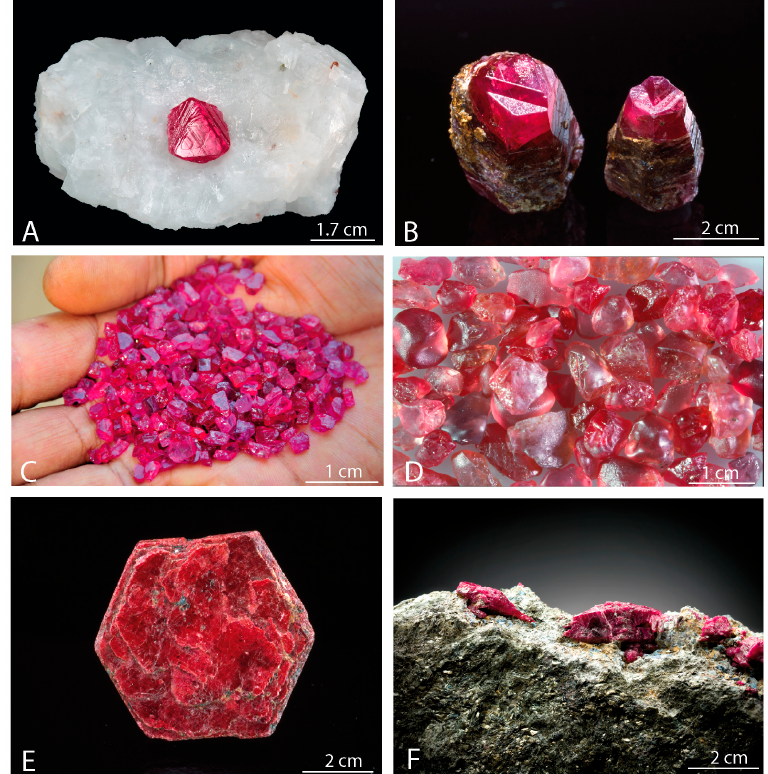
Figure 1. Rubies worldwide. ( A ) Ruby crystal (1.7 cm × 1.7 cm × 0.5 cm) in marble from Bawpadan, Figure 1. Rubiesworldwide. ( A )Rubycrystal(1.7cm × 1.7cm × 0.5cm)inmarblefromBawpadan, Mogok, Mogok, Myanmar. Photo: Louis-Dominique Bayle © le Règne Minéral; ( B ) rubies (from left to right: Myanmar. Photo: Louis-Dominique Bayle © le R è gne Min é ral; ( B ) rubies (from left to right: 2.1 cm × 1.3 2.1 cm × 1.3 cm × 1.3 cm and 1.7 cm × 1 cm × 1 cm) from Ambohimandrosoa, Antsirabe area, cm × 1.3 cm and 1.7 cm × 1 cm × 1 cm) from Ambohimandrosoa, Antsirabe area, Madagascar. Madagascar. Collection: L. Thomas; Photo: Louis-Dominique Bayle © le Règne Minéral; ( C ) rubies